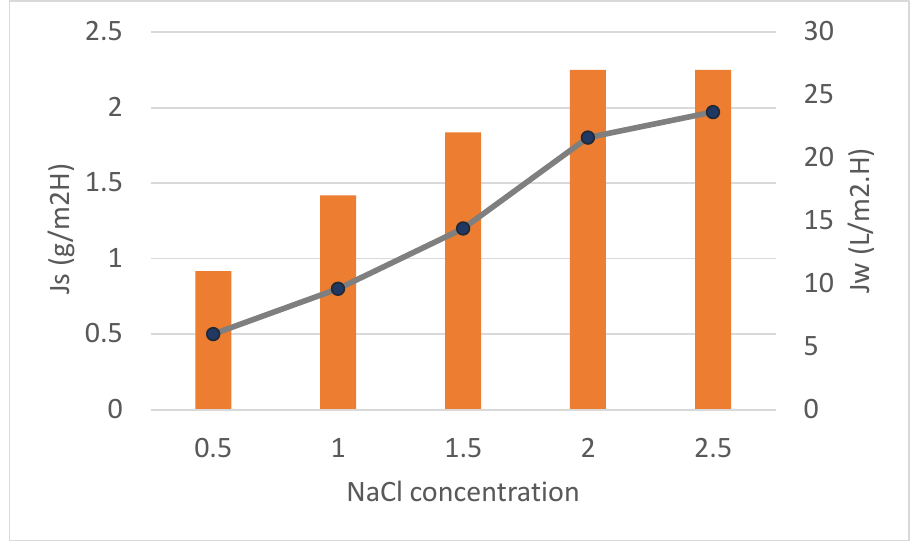
Figure 8. The effect of NaCl concentration as a draw solution using CTA/0.3% GO under constant operating conditions.